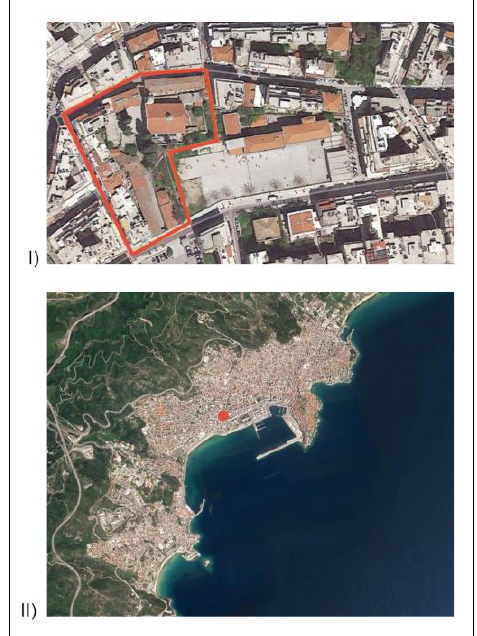
Figure 2 . The location of (I) the historical complex of Saint